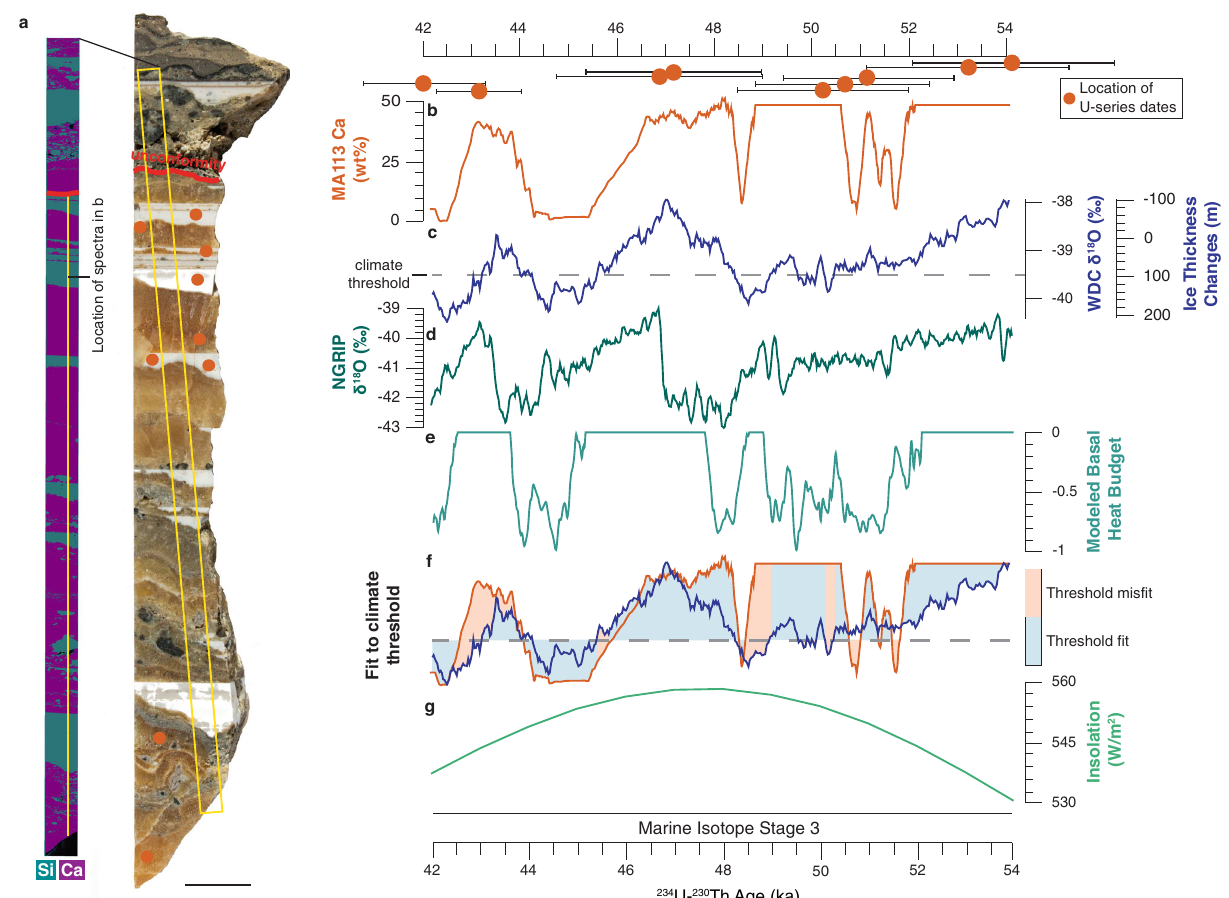
Fig. 2 | Sample MA113 SEM-EDS image and comparison to climate records. a SlabandSEM-EDSimageofsampleMA113.Scalebaris1cm. b Caconcentrationof subglacial precipitate sample MA113. High values represent calcite precipitation; low values represent opal precipitation. U-series dates include 2 σ uncertainties bars. c δ 18 O measured in West AntarcticDivide IceCore (WDC) 107 . Gray dashed line delineatesthresholdvalueformagnitudeoficethicknesschangenecessarytoelicit subglacial hydrologic response. d δ 18 O measured in Northern Greenland Ice Core Project (NGRIP) 108 . e Reduced complexity model of ice sheet thermodynamics (RCMIST) output of basal heat budget over the formation timeframe of sample MA113 in units of mm/year of equivalent basal freezing rate. Negative values indi- cate freezing. Positive values correspond to basal melting and are truncated at